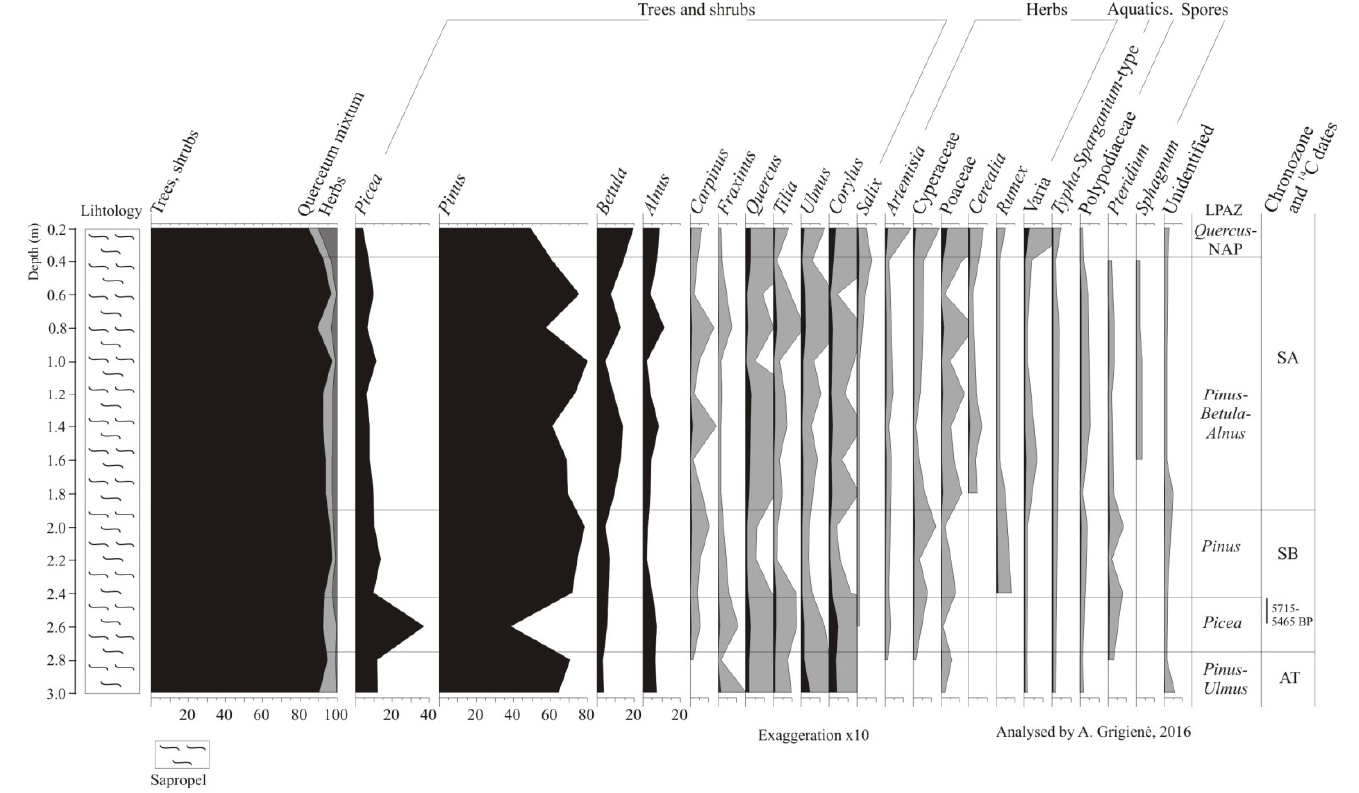
Figure 3. Percentage pollen diagram of the core from Lake Balsys. The radiocarbon 14 C dating (Figure 3) of the sample from the depth 2.6 m yield age of 5715–465 cal year BP and this result supports the biostratigraphical interpretation of the pollen